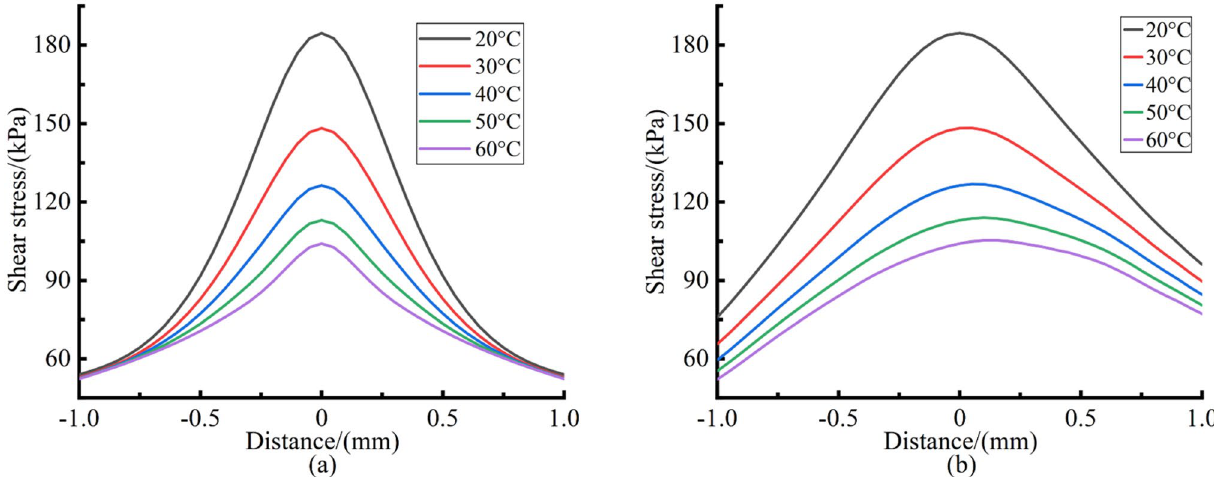
Figure 7. Shear stress distribution curves. ( a ) Along the X axis; ( b ) Along the Z